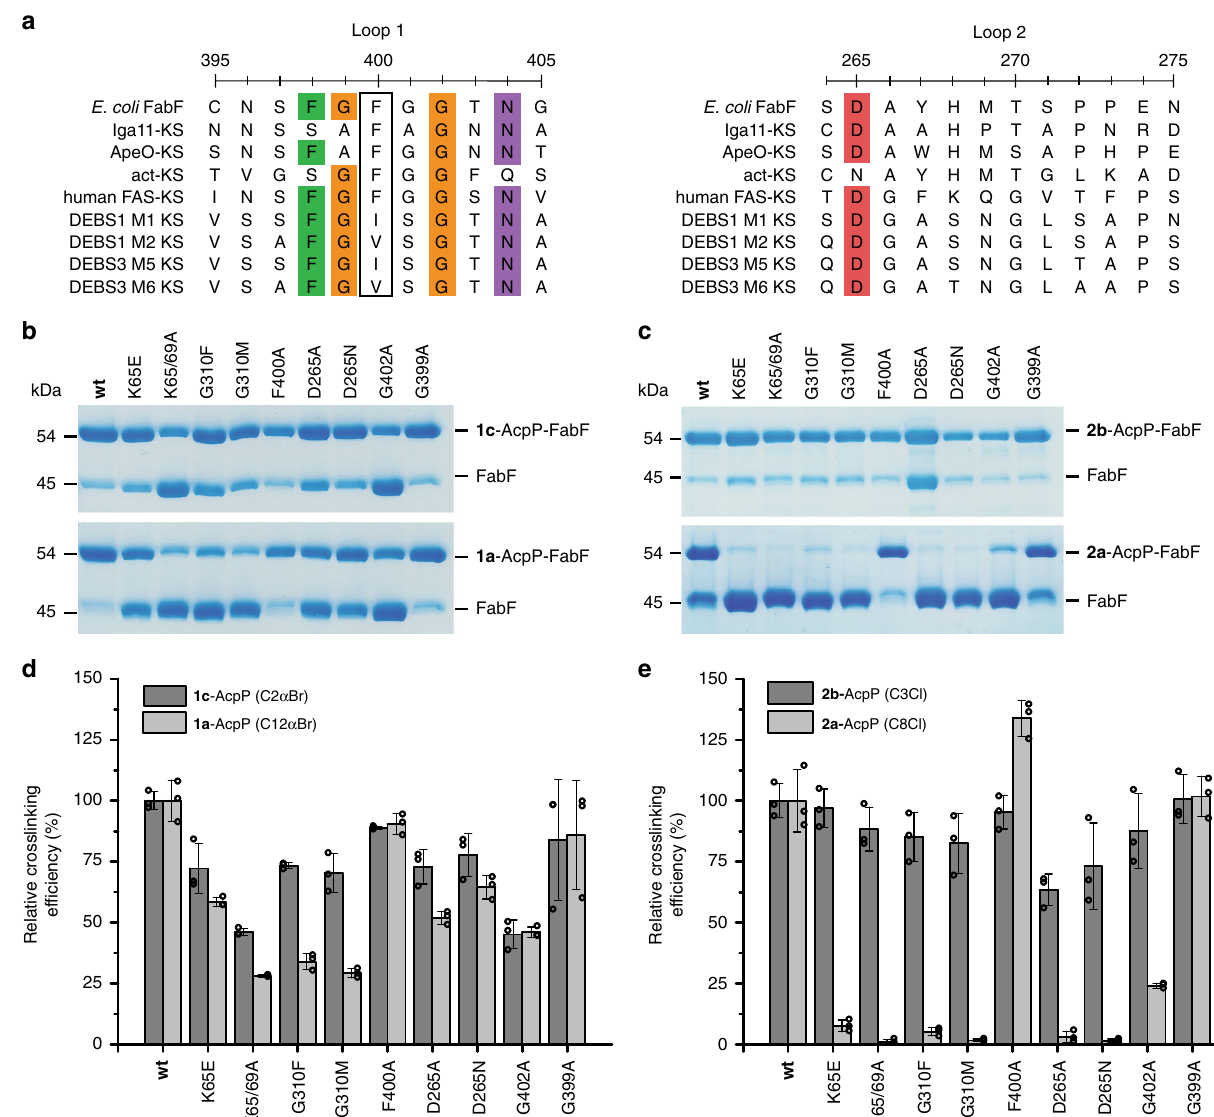
Fig. 6 Loop 1 and 2 Sequence conservation and mutagenesis. a Sequence alignment of loops 1 and 2 of FabF with representative KS sequences from non- iterative type II PKS (Iga11, ApeO), iterative type II PKS (act-KS), type I FAS (Human-FAS-KS), and type I PKS (DEBS KSs). The putative gating residue (Phe400 in FabF) for each synthase is outlined in a black box. b Single time point crosslinking gels of 1c -AcpP (C2 α Br-AcpP) and 1a -AcpP (C12 α Br-AcpP) with FabF gating mutants. c Single time point crosslinking gels of 2b -AcpP (C3Cl-AcpP) and 2a -AcpP (C8Cl-AcpP) with FabF gating mutants. d Densitometric analysis of single time-point crosslinking ef fi ciency of 1c -AcpP (C2 α Br-AcpP) and 1a -AcpP (C12 α Br-AcpP) with FabF mutants. e Densitometric analysis of single time-point crosslinking ef fi ciency of 2b -AcpP (C3Cl-AcpP) and 2a -AcpP (C8Cl-AcpP) with FabF mutants. All crosslinking experiments from b and c were performed as biologically independent experiments ( n = 3) and all data represented in d and e are the average crosslinking ef fi ciency of each mutant normalized to the average of wt FabF crosslinking ef fi ciency. The error bars in d and e are represented as standard deviation (±SD) and the individual normalized measurements from each independent experiment are overlaid on top of the associated bar plot as open circles. Source data for all experiments are provided as a Source Data fi